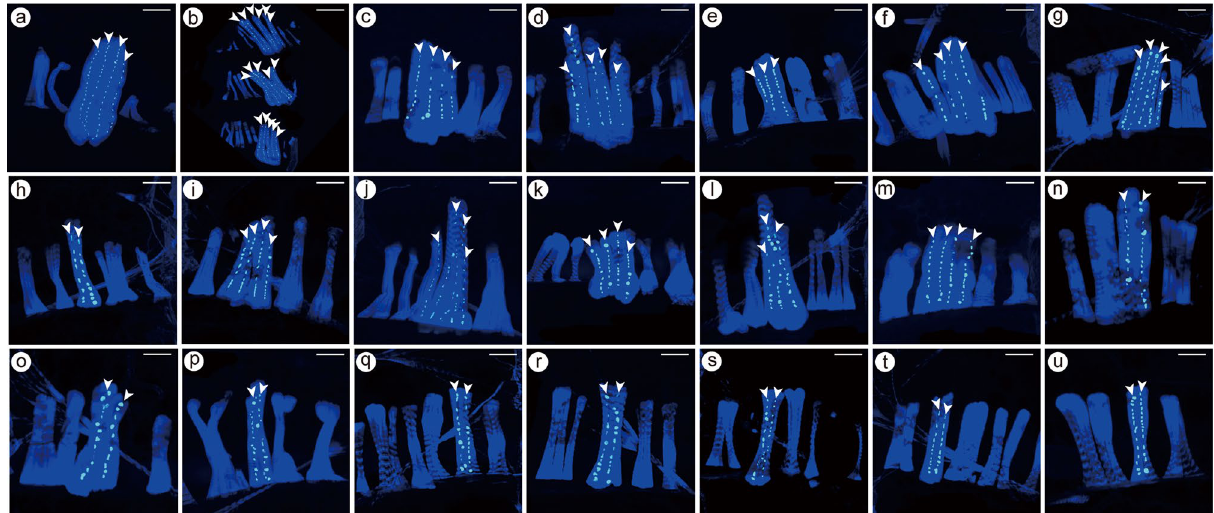
Figure 4. Inter-species variations in the number of fibers composing an MOL or MOL-analog. White dots represent the position of nuclei recorded on a transparency (see Materials and Methods), which aligns along a longitudinal axis, visualizing a single fiber composing the MOL or MOL-analog. Shown are representative examples of MOL nuclear alignments in D. melanogaster ( a ), D. subobscura ( b ), D. baimaii ( c ), D. barbarae ( d ), D. birchii ( e ), D. bocki ( f ), D. diplacantha ( g ), D. fengkainensis ( h ), D. greeni ( i ), D. kikkawai ( j ), D. lacteicornis ( k ), D. leontia ( l ), D. mayri ( m ), D. ogumai ( n ), D. ohnishii ( o ), D. pectinifera ( p ), D. serrata ( q ), D. trapezifrons ( r ), D. truncata ( s ), D. tsacasi ( t ) and D. watanabei ( u ). Scale bars: 50 μm.